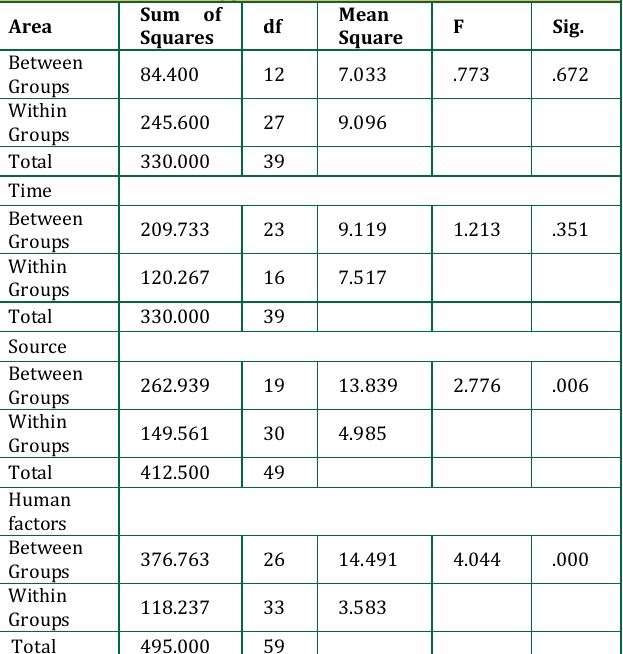
Table 6: Significant test results include area, time, resources and type of human factors